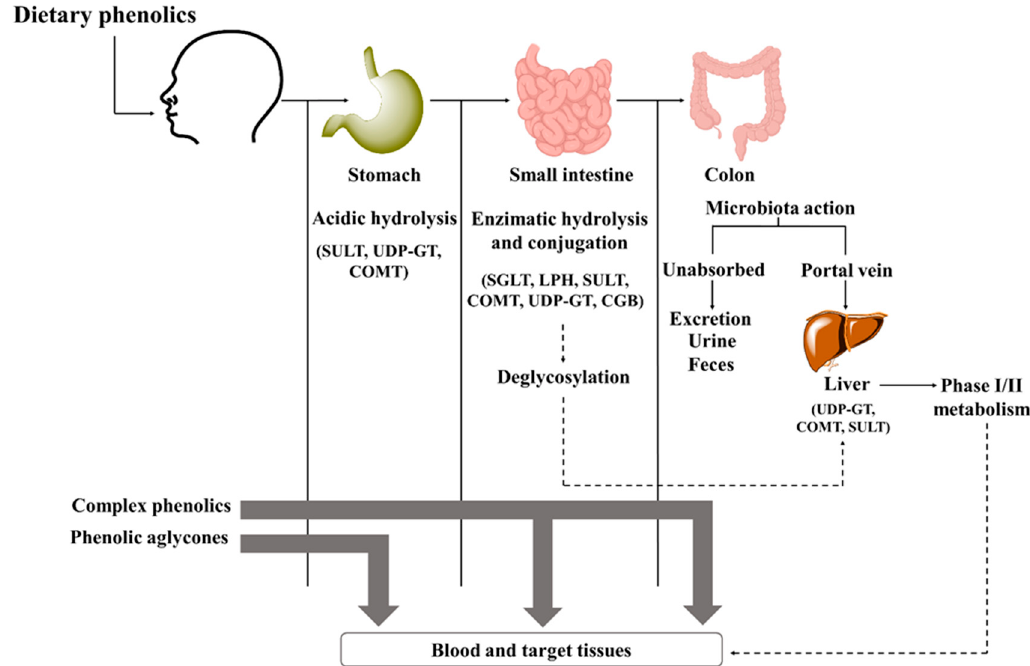
Figure 2. Simplified steps of the metabolic pathways involved in the bioavailability of phenolics in the human body after consumption. CGB—cytosolic β -glucosidase; SULT—sulfotransferase; UDP- GT—glucuronosyltransferase; COMT—catechol-O-methyl transferase; SGLT—sodium-dependent glucose cotransporters; LPH—lactase-phlorizin hydrolase.